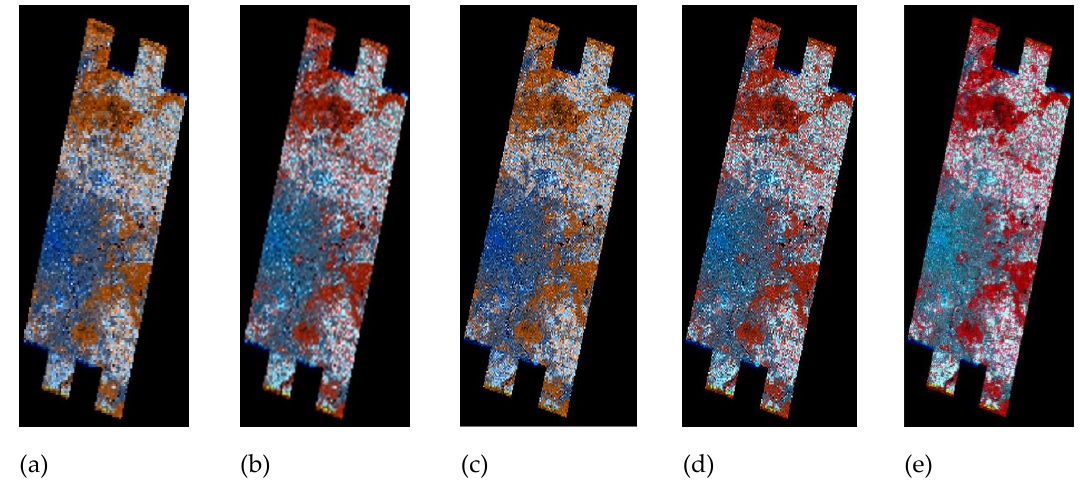
Figure 10. RGB compositions of ( a ) Indusion + Arad method, ( b ) Indusion + SREM method, ( c ) SparseFI + Arad method, ( d ) SparseFI + SREM method, ( e ) Proposed J-SpeSpaRE method.